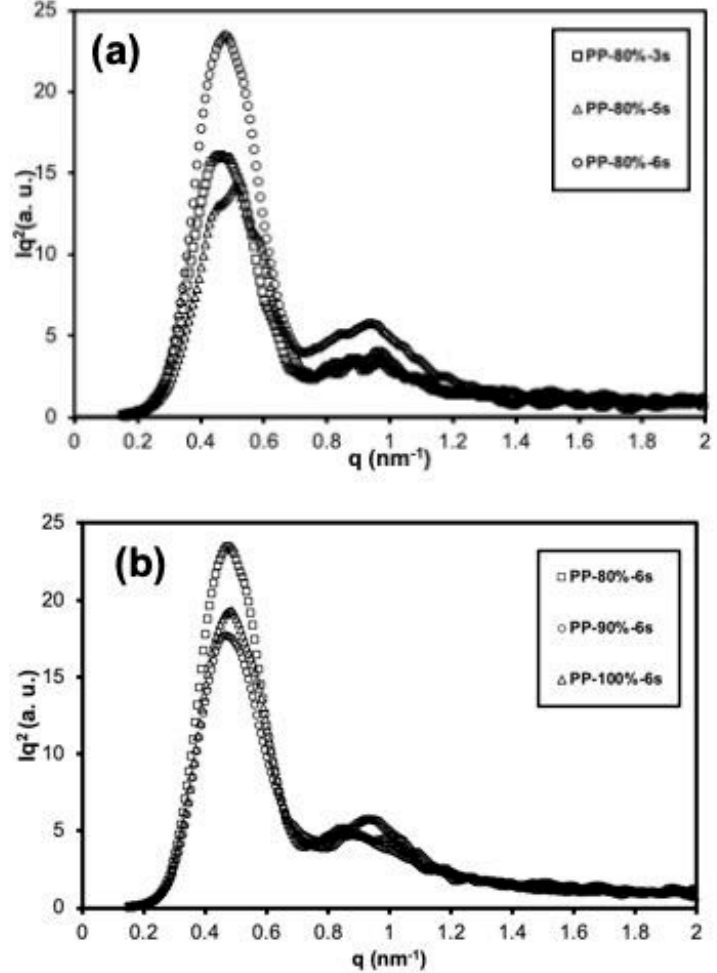
Figure 9. Lorentz corrected 1-D SAXS profiles of iPP specimens injected at two conditions: ( a ) constant amplitude (80%) with different ultrasound times (3 s, 5 s, and 6 s), and ( b ) constant ultrasound time (6 s) and different amplitudes (80%, 90%, and 100%). Table 3. Scattering vector (q) and long-period (L) values obtained from 1D-SAXS patterns for vari- ous UMIM specimens.